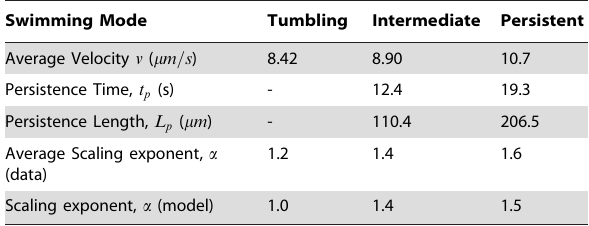
Table 1. Summary of trypanosome motility modes.